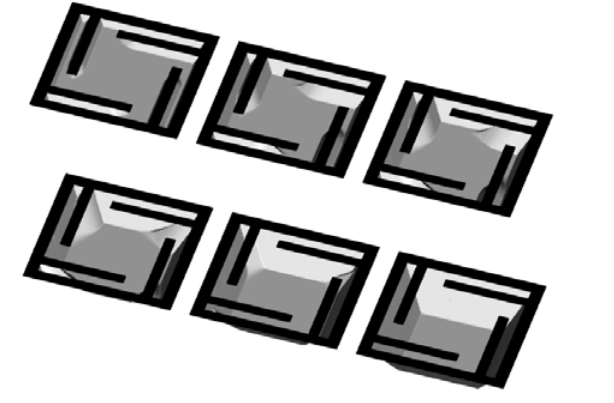
Figure 11 . Formation of a system of suspended cantilever beams. Initial aperture is aligned to <110> directions.